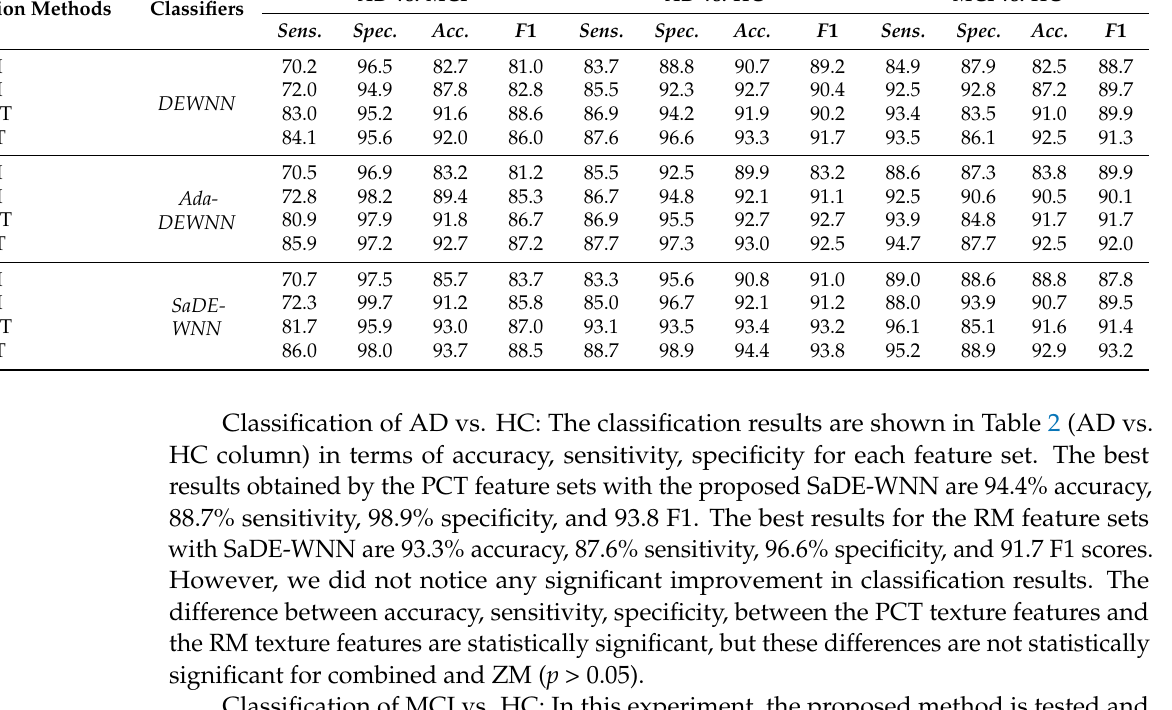
Table 2. Experimental results for comparative analysis of the Self-adaptive Differential Evolution Wavelet Neural Network (SaDE-WNN) with Differentially optimized WNN (DEWNN) and Ada-DEWNN. Results are compared on the features extracted by non-orthogonal moments (RM) and orthogonal moments (ZM, PCET, and PCT). Feature Extraction Methods